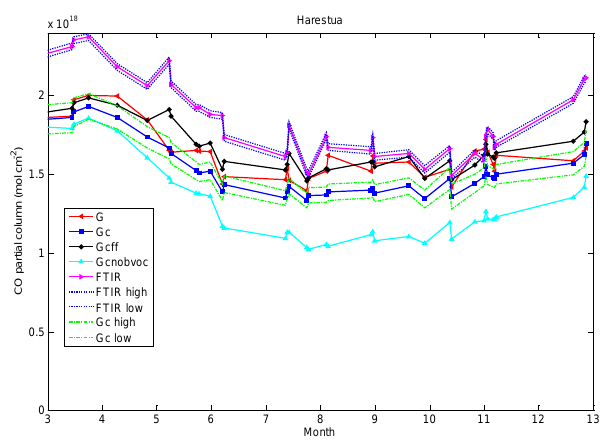
Figure 5. Uncertainty analysis for the global-scale EMEP model performed at Harestua data. Except three model versions the interpolation limits for the model with convection is presented (Gc high and low), the FTIR upper and lower uncertainties for the partial columns (FTIR high and low) and one sensitivity scenario when all North American BVOC is removed (Gcnobvoc).